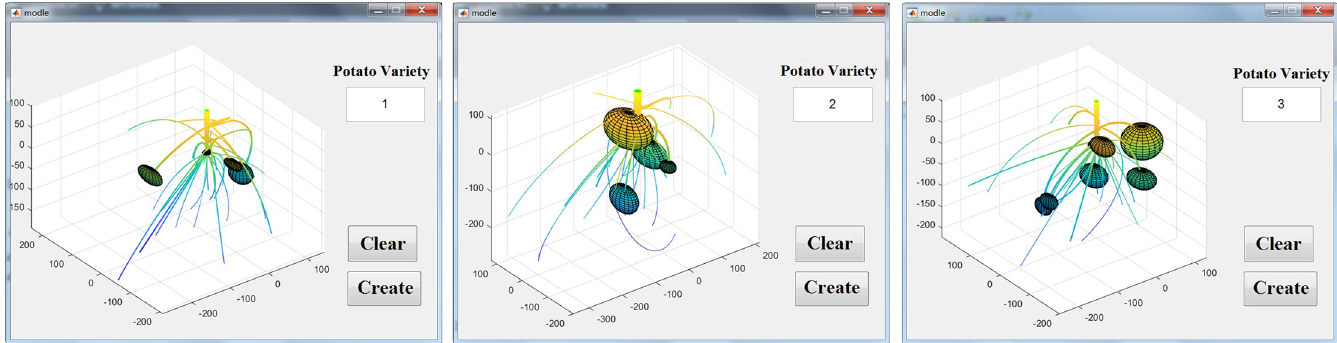
Fig 17. Visualization of different potato models. (a) Zaodabai; (b) Helanshiwu; and (c) Fujin. https://doi.org/10.1371/journal.pone.0239093.g017 simulation accuracy into four levels [30]. When RRMSE is less than 10%, it indicates that the consistency between the simulated and measured values is extremely significant. When